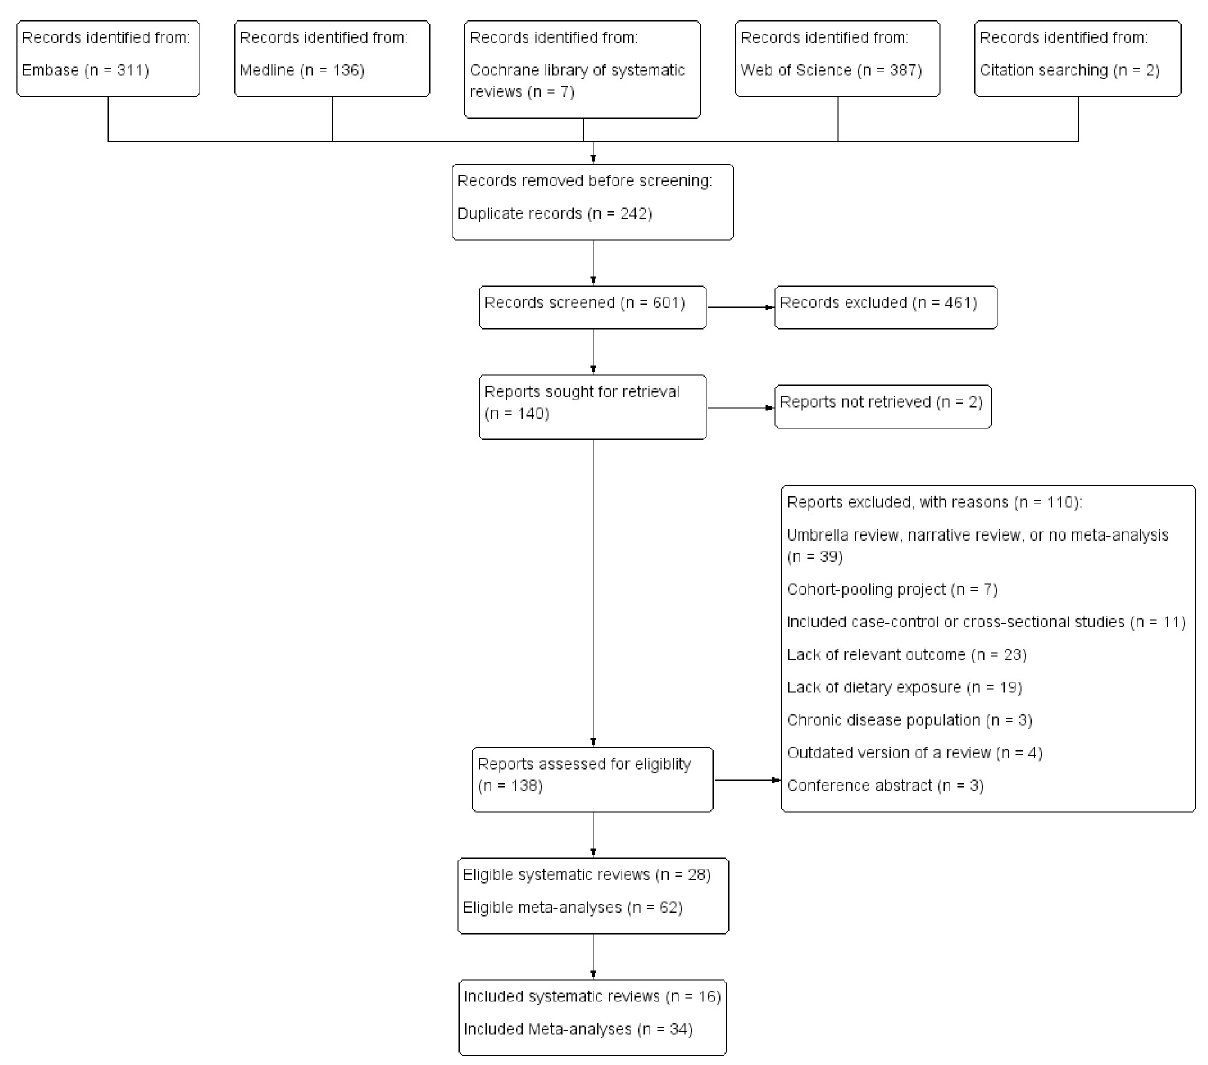
Fig 1. PRISMA flow diagram of the study selection